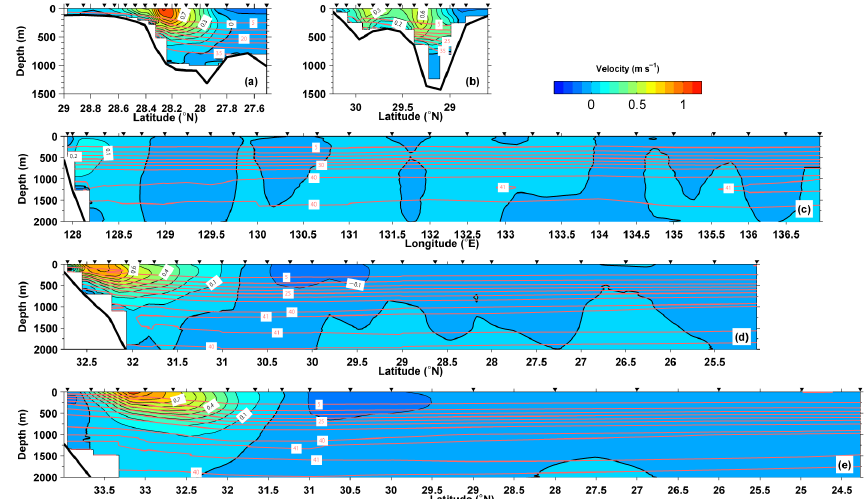
Fig. 3. Temporally averaged absolute geostrophic velocity (ms − 1 ) and nitrate concentration (mmolm − 3 ) for all five sections. Colored areas and black contours show velocity with an interval of 0.1ms − 1 . Positive values are defined as the direction of the Kuroshio or Ryukyu Current. Red contours indicate nitrate concentrations at an interval of 5mmolm − 3 , with the exception of 41mmolm − 3 . Thick black lines indicate a speed of zero. The inverse triangles denote the hydrographic stations where water temperature, salinity, and nitrate concentrations are